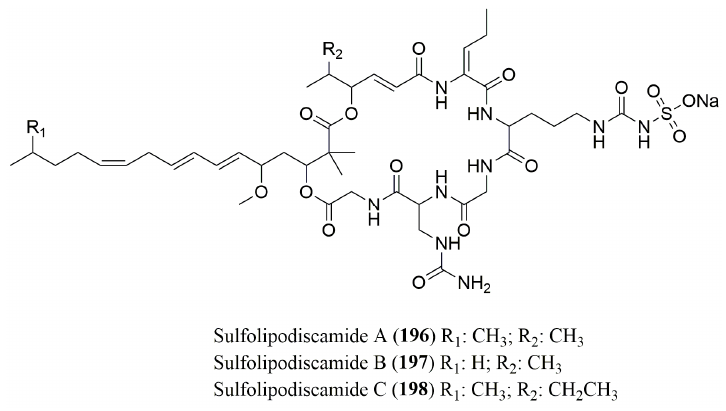
Figure 14. Structure of cyclic lipopeptides 196 – 198 , isolated from marine sponges. Table 8. Lipopeptides from marine sponge.